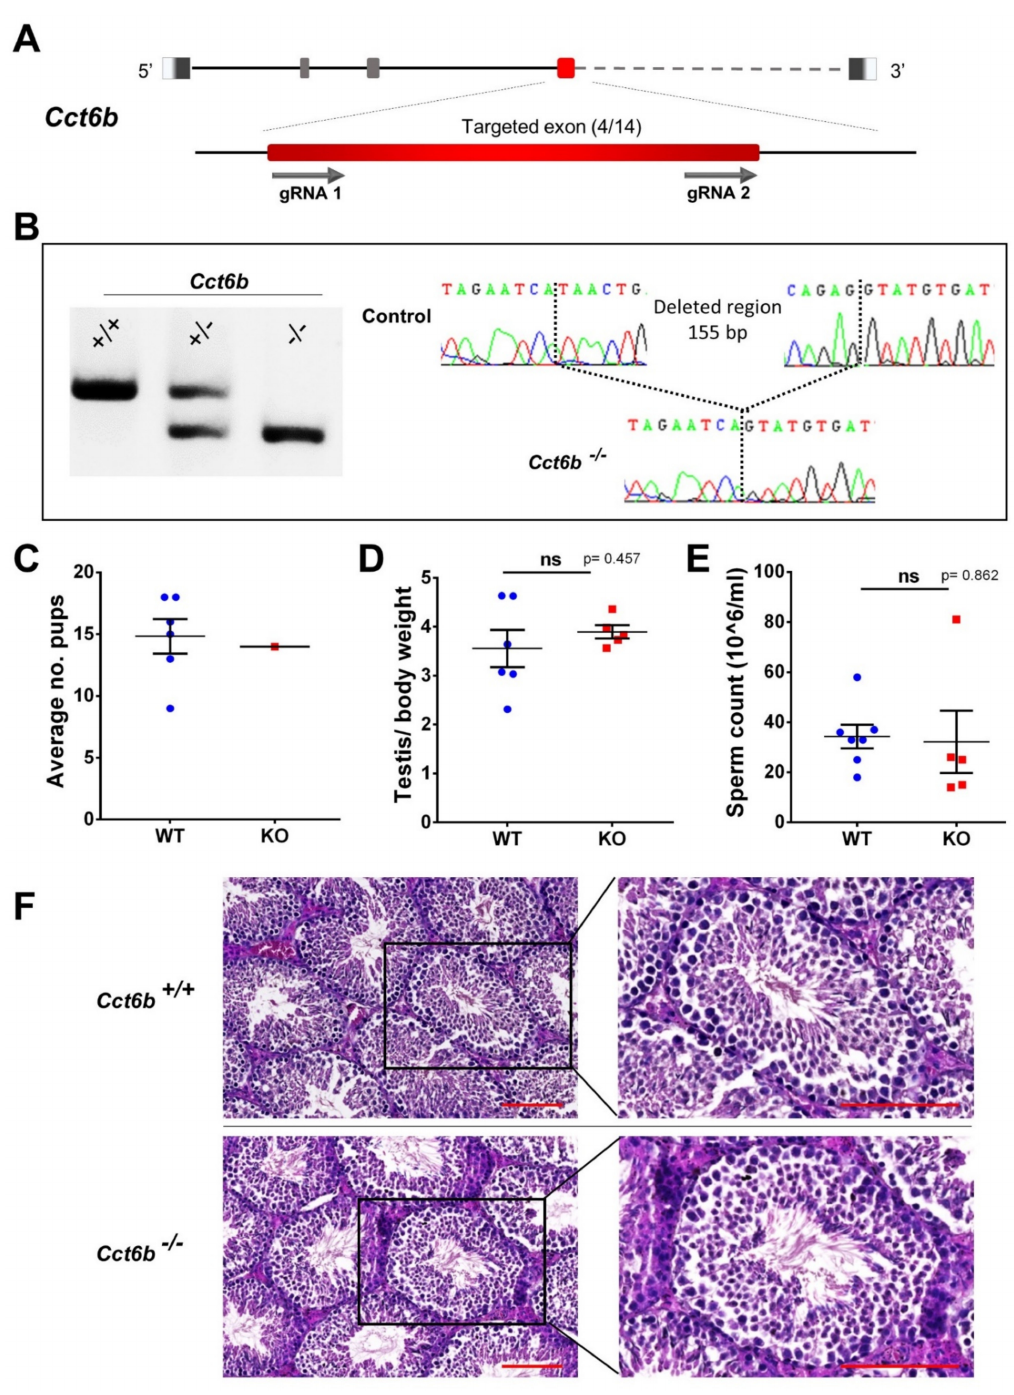
Figure 3. Cct6b editing, genotyping strategy, and phenotypic analyses of mutated animals. ( A ) Schematic presentation of Cct6b highlighting the targeted exon in red (exon 4/14) and showing the approximate location of the sequences targeted by the dual gRNAs. ( B ) Gel electrophoreses of the PCR products using a primer set that amplifies the region containing the intra-exonic deletion. DNA fragments migrate according to their molecular size (WT allele: 535 bp and KO allele: 380 bp). Genotyping strategy was completed by Sanger sequencing of PCR products for F0–F1 generations. ( C ) Litter size of WT and KO males (a single litter was recorded due to a short mating period). ( D ) Comparison of testis to body weight ratios between WT ( n = 6) and KO ( n = 5) animals. ( E ) Com- parison of sperm count between WT ( n = 7) and KO ( n = 5) animals. ( F ) Histological analyses of WT and KO testicular sections after hematoxylin and eosin staining. Scale bars = 100 µ